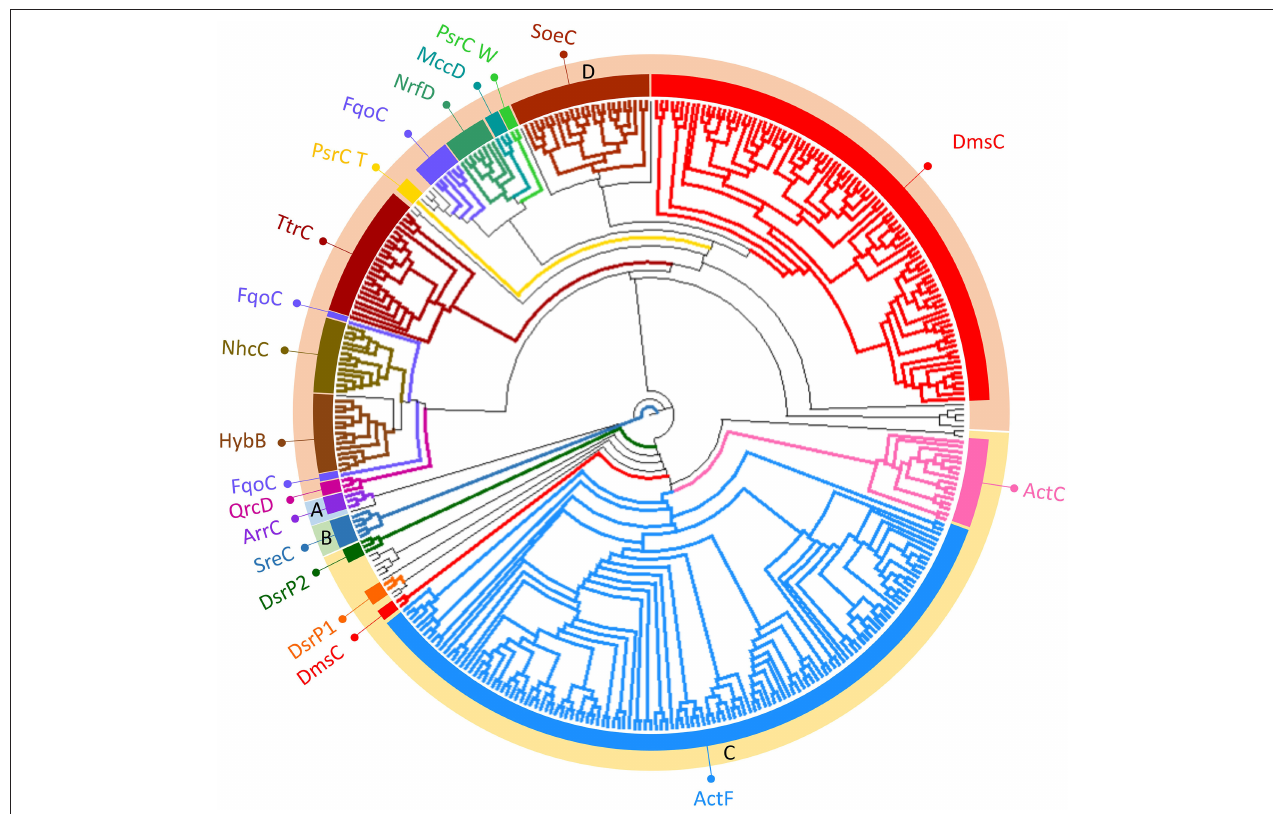
FIGURE 4 | Neighbor-Joining dendrogram of the NrfD-like subunits. The dendrogram was obtained using 551 representative sequences of NrfD-like subunit sequences. Branches are colored according to the color code indicated in the Figure 1 . The external ring of the dendrogram indicates the four major identified groups discussed in the text (groups A to